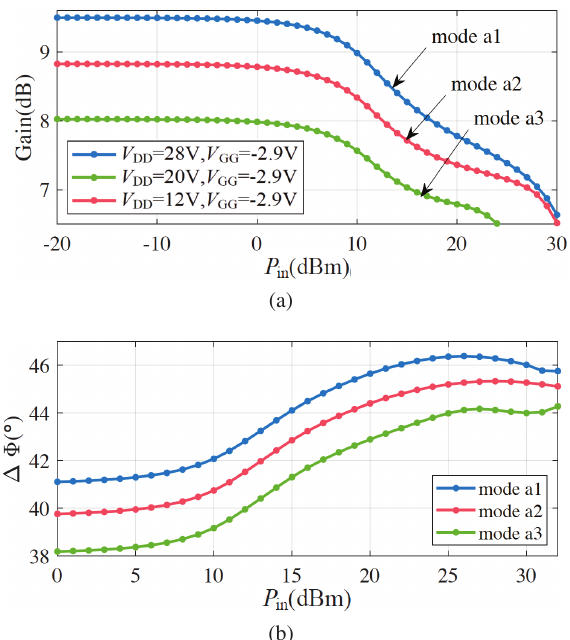
Figure 8. Nonlinear characteristics of Class AB. ( a ) Gain curves versus input power at Class AB. ( b ) AM/PM characteristic of Class